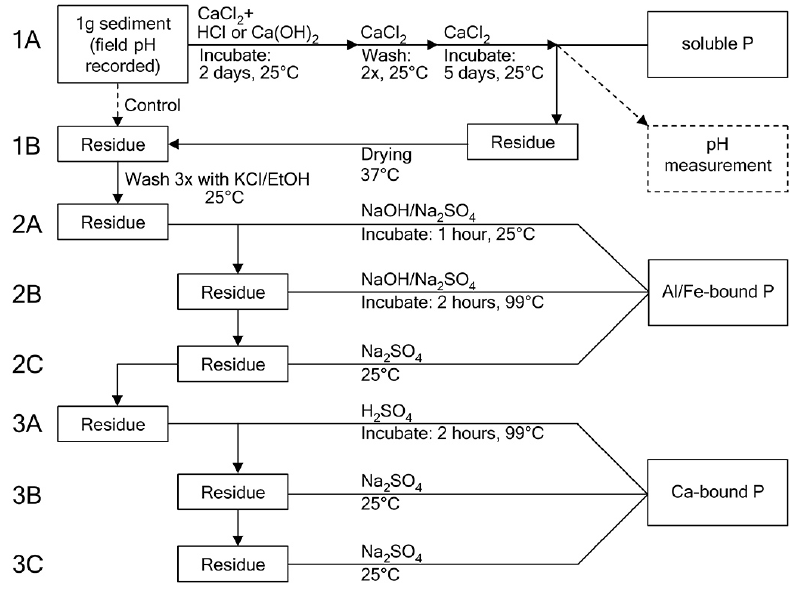
Figure 3. CONVEX scheme for the quantification of phosphorus species in sediment. 1A/1B: conversion procedure, 2A–3C: extraction procedure. For addition experiments, reference minerals were added to the sediment subsamples before incubation. Adapted from Oxmann et al.